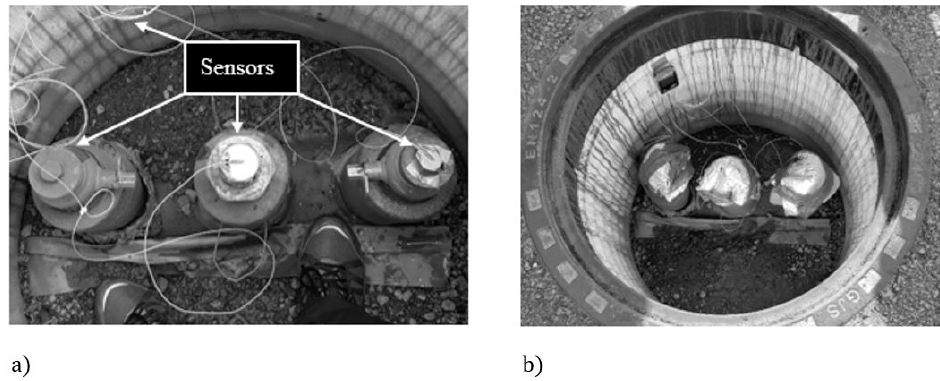
Figure 10. ( a ) Measurement set-up in the manhole, showing thermocouples attached to the three valves and one to the side of the manhole to capture the air temperature; ( b ) the valves insulated with mineral wool (the valve set-up is the same as in Figure 6).